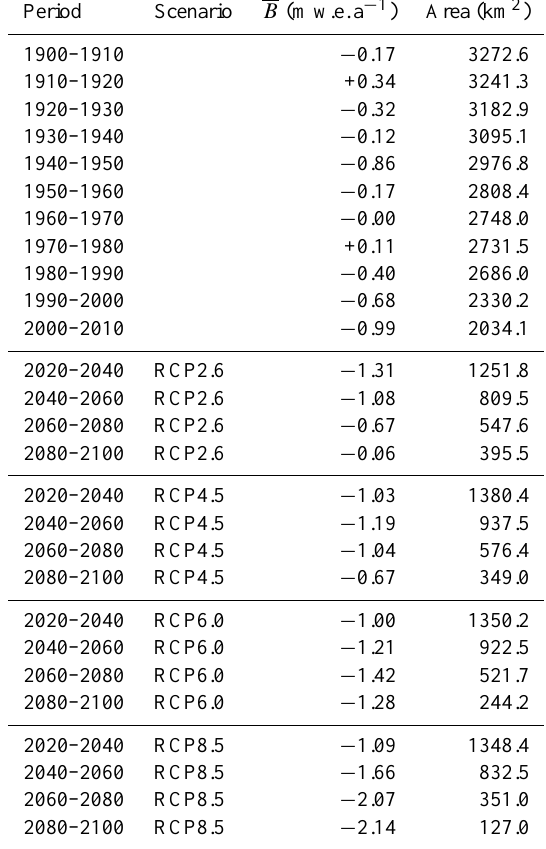
Table 3. Decadal mean mass balances of glaciers in the European Alps for 1900–2010 and simulated future mass balance in 20-yr periods according to the four RCPs based on the GCM ensemble mean. Period averages of total Alpine glacier area are